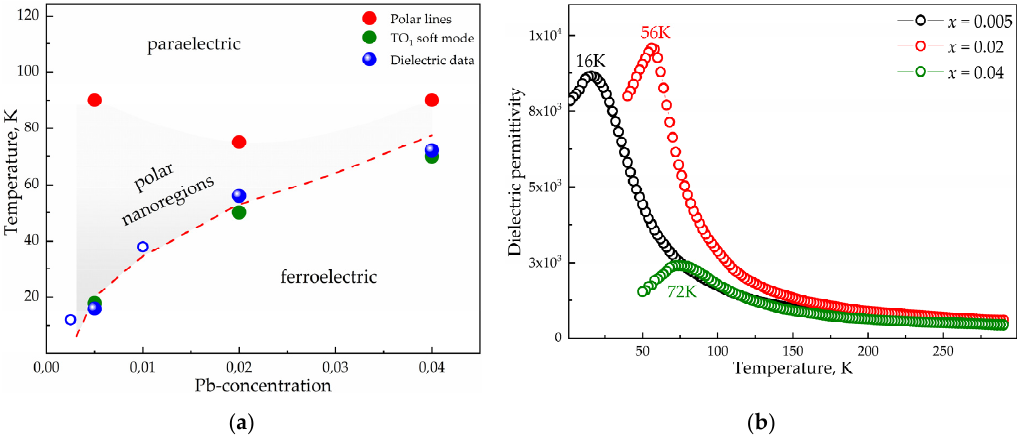
Figure 6. ( a ) Characteristic temperatures of the emergence of the polar nanoregions (red circles) and critical temperatures of the ferroelectric transition (green and blue circles) for different Pb concentrations x. The filled red and green circles correspond to the Raman measurements, and the filled blue circles to the dielectric measurements. The empty blue circles correspond to the dielectric data obtained in Ref. [32]. The high-temperature area of the plot corresponds to the paraelectric phase of PST x , the intermediate shaded area corresponds to the emergence of the polar nanoregions, and the low-temperature area corresponds to the ferroelectric phase. The dashed red line gives the fit of the results by theoretical 1 formula, T c = A ( x − x c ) 2 . ( b ) Temperature dependence of the dielectric permittivity for different Pb concentrations x